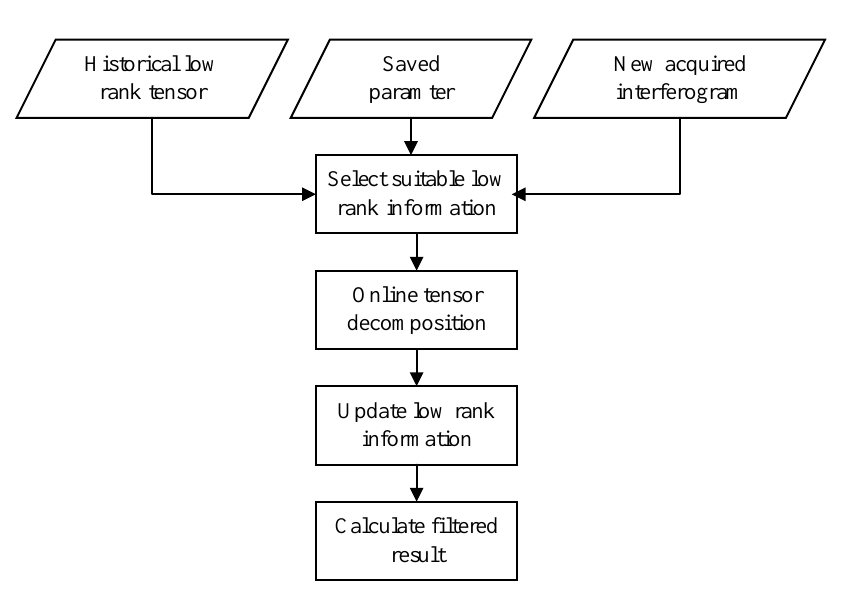
Figure 7. Flow chart of OLCP-InSAR for matrix model (Algorithm 2).